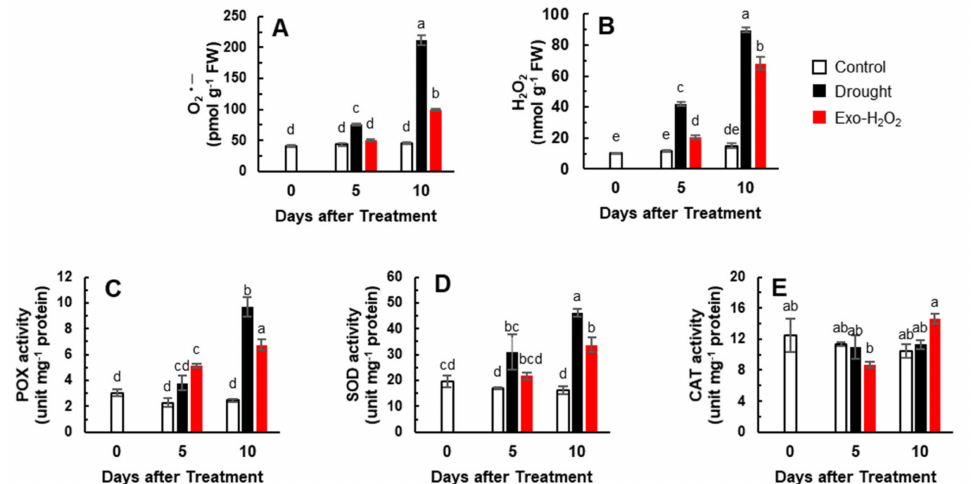
Figure 1. Changes in the concentration of ROS and in the activity of antioxidative enzymes in the leaves of control, drought − , or exogenous H 2 O 2 (Exo − H 2 O 2 ) − treated plants for 10 days. ( A ) O 2 • – and ( B ) H 2 O 2 concentration, ( C ) peroxidase (POX), ( D ) superoxide dismutase (SOD), and ( E ) catalase (CAT) activity. Results are represented as mean ± SE for n = 3. Different letters indicate values that are significantly different at p < 0.05 according to Duncan’s multiple range